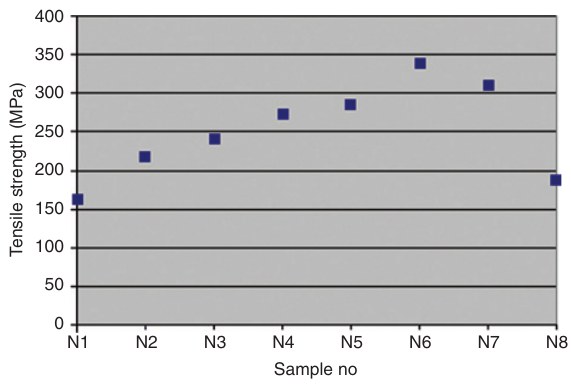
Figure 16 Shear-lap test results of the test